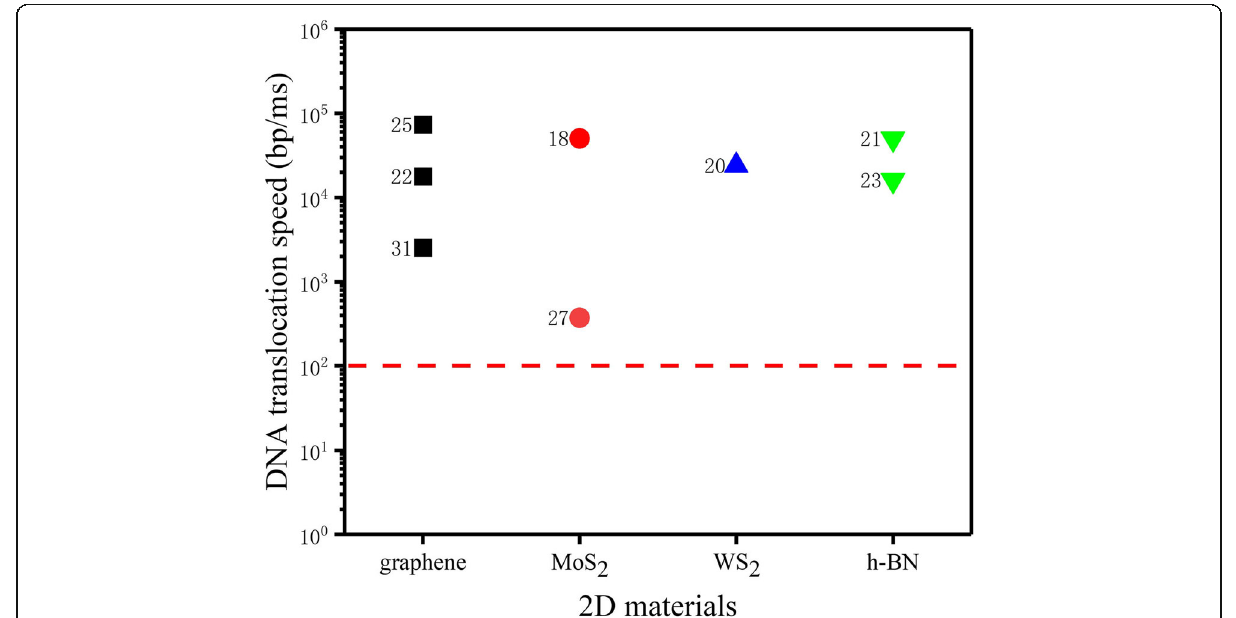
Fig. 1 DNA translocation speed of 2D solid-state nanopore [18, 20 – 23, 25, 27, 31]. The dotted red line indicates a DNA translocation rate of 100